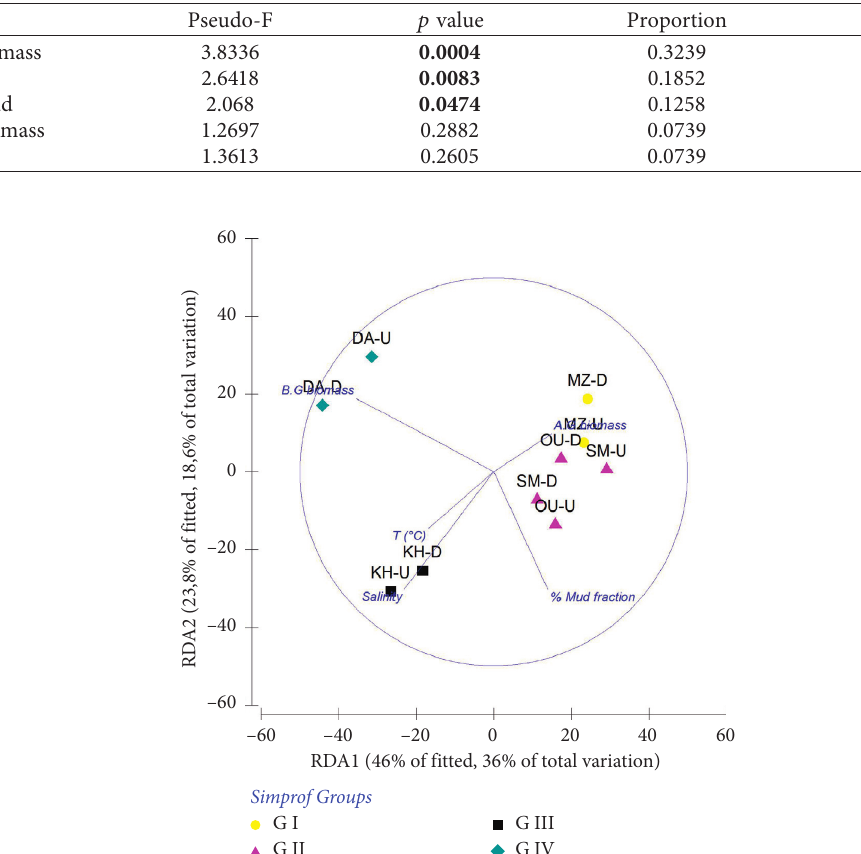
Figure 4: Two-dimensional distance-based redundancy analysis (dbRDA) ordination representing the model of spatial variation in macrofaunal community structure related to the predictor variables selected through the best linear models based on distance